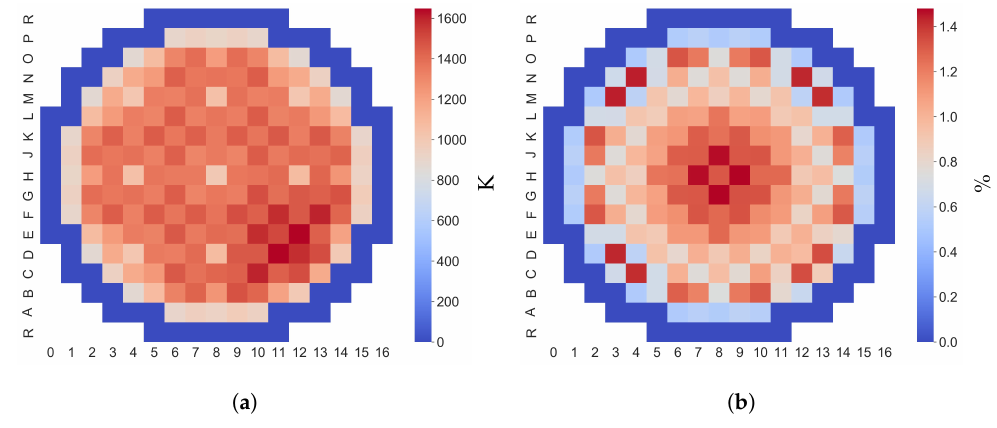
( a ) mean and ( b ) standard deviation. fc,end